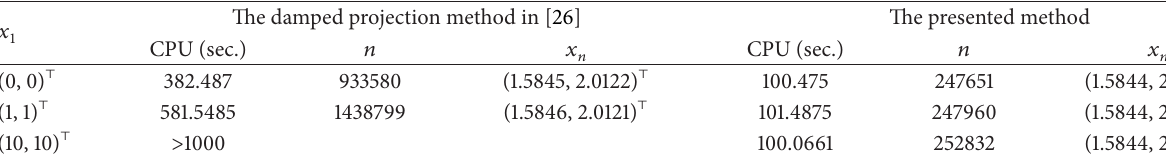
Table 3: Numerical results for Example 13.